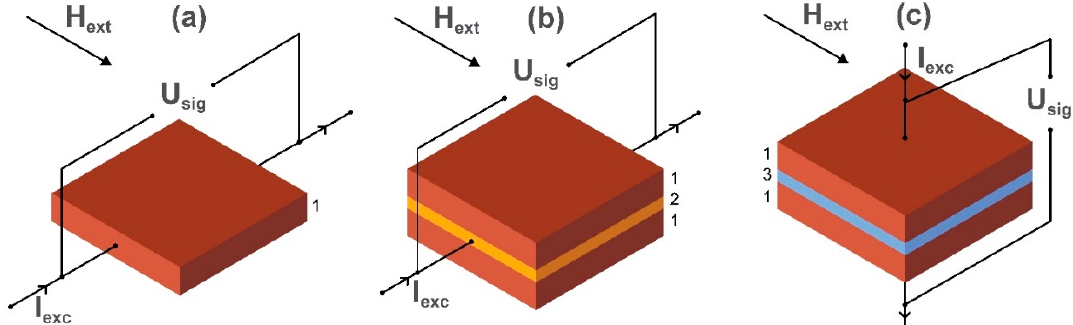
Figure 5. Schematic images of the sensing elements of ( a ) anisotropic magnetoresistance, ( b ) giant magnetoresistance, and ( c ) tunneling magnetoresistance magnetic field sensors, where I exc is a current flowing through the film made from ferromagnetic material (AMR element (1)), non-magnetic material (spacer layer in the GMR element (2)) or insulating material (barrier layer in the TMR element (3)), respectively. U sig is a voltage detected in a direction perpendicular to the external magnetic field H ext .